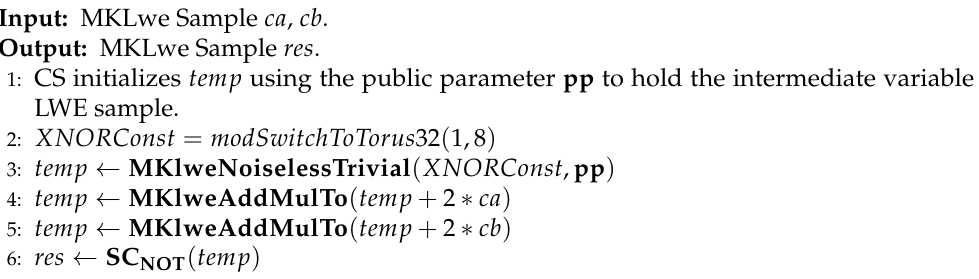
Algorithm 3 Secure XNOR gate computation protocol ( SC XNOR